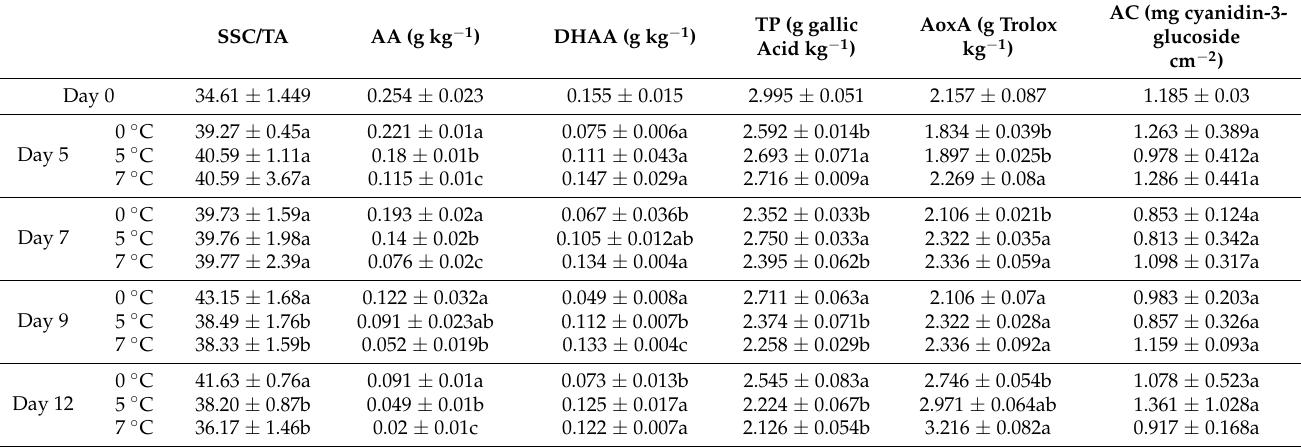
Table 4. Chemical and nutritional quality of goji berries stored for up to 12 days at 0, 5, and 7 ◦ C. SSC = Soluble solids content; TA = Titratable acidity; AA = Ascorbic acid; DHAA = Dehydroascorbic acid; TP = Total polyphenols; AoxA = Antioxidant activity; AC = Anthocyanin content.